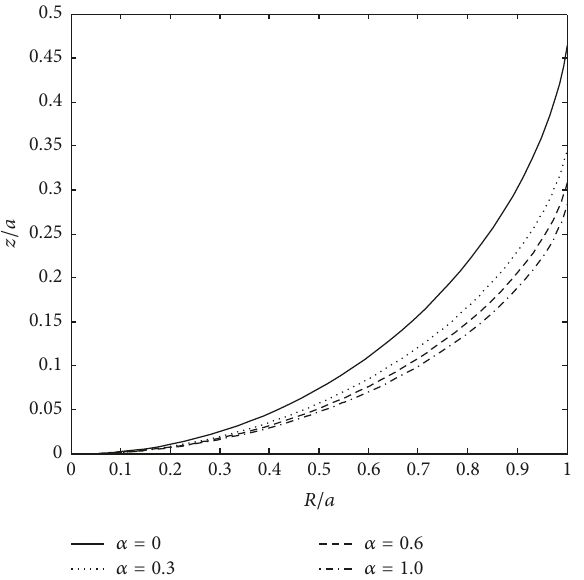
Figure 8: The vertical displacement curve of polymer membrane ( 𝑞/𝐴 = 10 ; 𝑛 = 2 ).